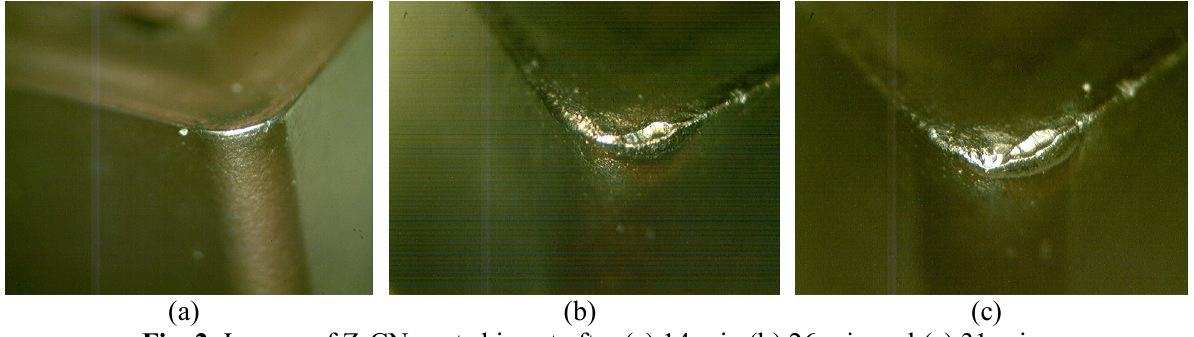
Fig. 2. Images of ZrCN coated insert after (a) 14 min (b) 26 min and (c) 31